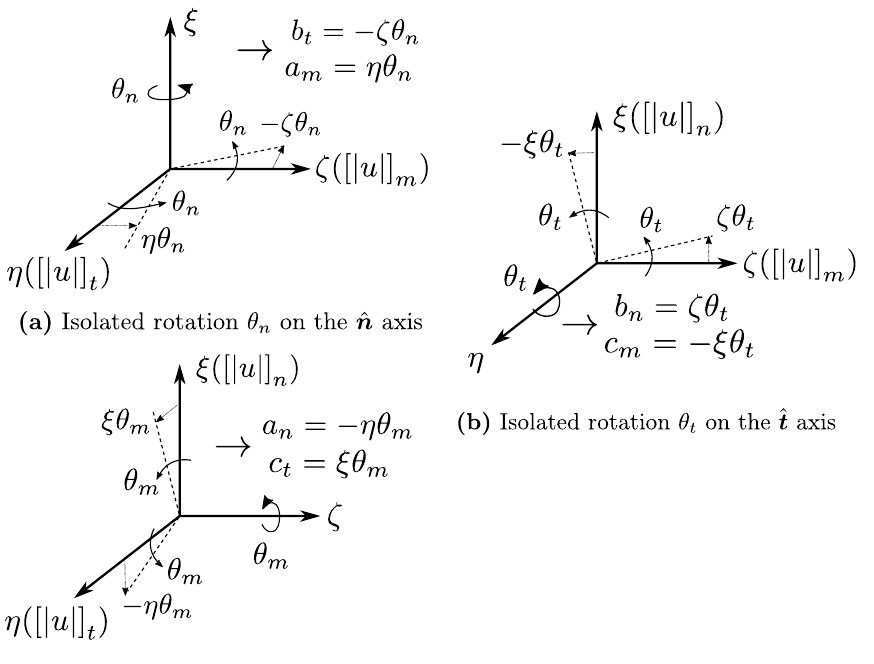
Figure 11. Relations between the parameters a i , b i , c i , d i and the rigid body rotation modes θ n , θ t , θ m . Note that two parameters may be influenced by the same rotation mode. Each plot ( a ), ( b ), ( c ) illustrates the effect of having a small rotation in the axes corresponding to θ n , θ t , θ m ,